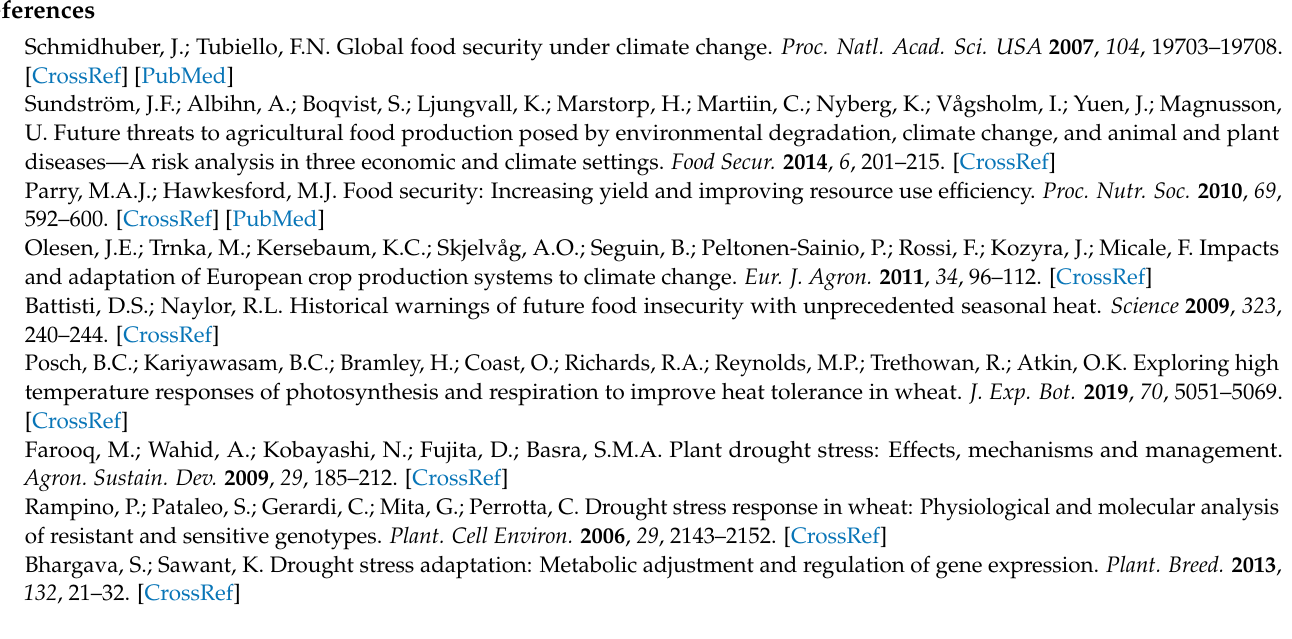
S2: Classification of the measured phenotypic traits into categories. Figure S3: Trait correlation via heatmap analysis. Figure S4: Analyzed side and top view RGB imaging. Figure S5: Correlation between fresh and dry weight with RGB data. Figure S6: Water use efficiency and correlation between plant volume and water consumption at the last day of stress. Figure S7: Light response curves after dark adaptation. Figure S8: Leaf pigment